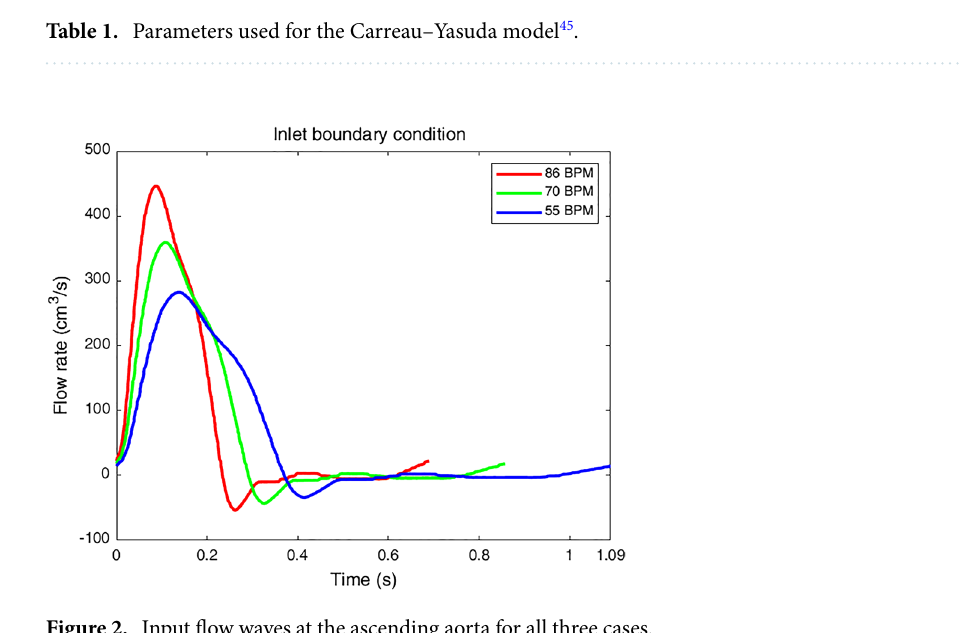
Figure 2. Input flow waves at the ascending aorta for all three